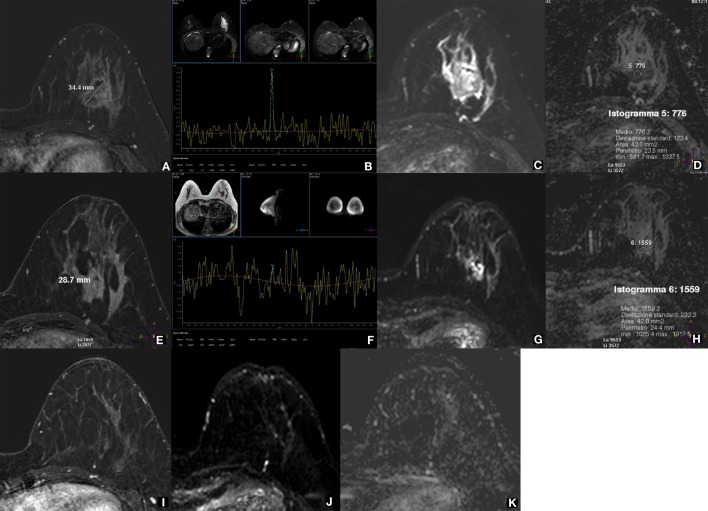
1H-MRS and DWI for evaluating the response to neoadjuvant therapy (NAT) of a locally advanced breast cancer. A 37-year-old woman with locally advanced breast cancer before, during, and after neoadjuvant therapy (NAT). Before treatment, the lesion at the lower external quadrant of the left breast is well depicted as a 34.4-mm nodule on subtracted CE-MRI with 0.1 mmol/kg of gadobenate dimeglumine (A), shows a high tCho peak at 1H-MRS with a signal-to-noise ratio (SNR) of 6.7 (B), low diffusivity as a high signal on DWI (C), and a low (0.776 × 10−3 mm2/s) mean ADC value (D). After two NAT cycles, the lesion is reduced in size (28.7 mm) at CE-MRI (E), while the tCho peak is no longer detectable at 1H-MRS (F); DWI (G) and ADC map (H) show an evident increased diffusivity (mean ADC 1.559 × 10−3 mm2/s). After the end of treatment, the lesion is not visible at all on CE-MRI (I), DWI (J), and ADC map (K); therefore, MRS was not performed. The lesion was a metaplastic carcinoma with condroid differentiation (negative for estrogen, progesterone, and HER2 receptors, Ki67 80%), and after surgical removal, a complete pathological response was appreciated. Both 1H-MRS and DWI early predicted the pathological response to NAT showing an effect more pronounced than that of CE-MRI. Acquisition times: CE-MRI 9 min; 1H-MRS 8 min (including preparation); DWI 5 min (Philips Achieva STx 3.0 T, MultiTransmit radiofrequency technology; dedicated 16-channel breast coil; Azienda Ospedaliera Universitaria Integrata, Verona, Italy).